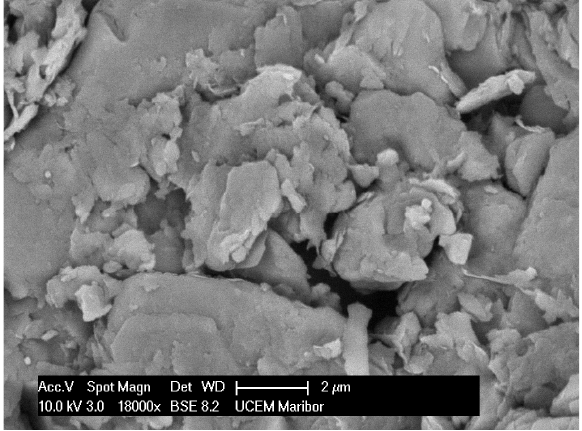
Figure 3. 18,000-time magnification of clay.